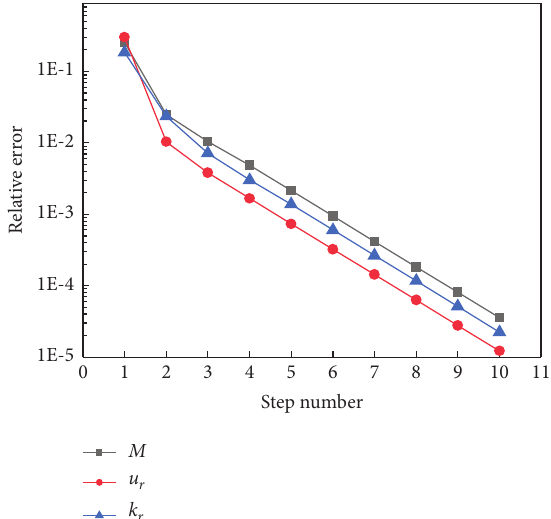
Figure 10: The convergence of the relative